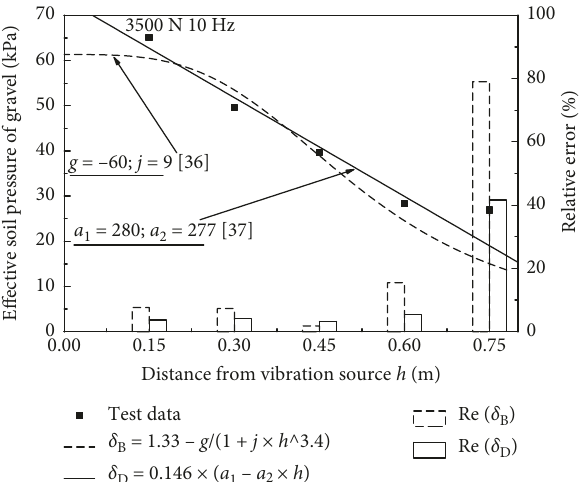
Figure 18: Test results and empirical formulae at different measurement points in the case of three jacks (gravel).